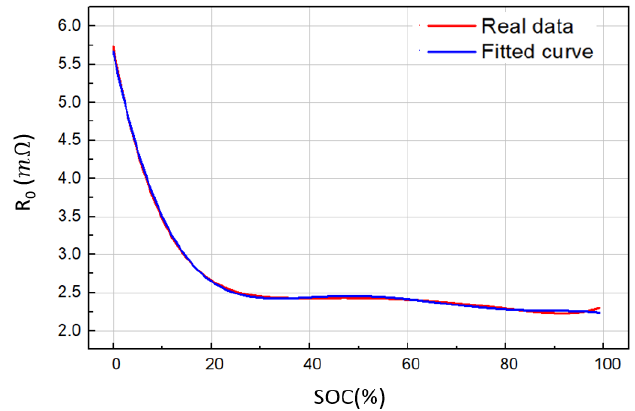
Figure 8. R 0 and SOC curve of the LiB.